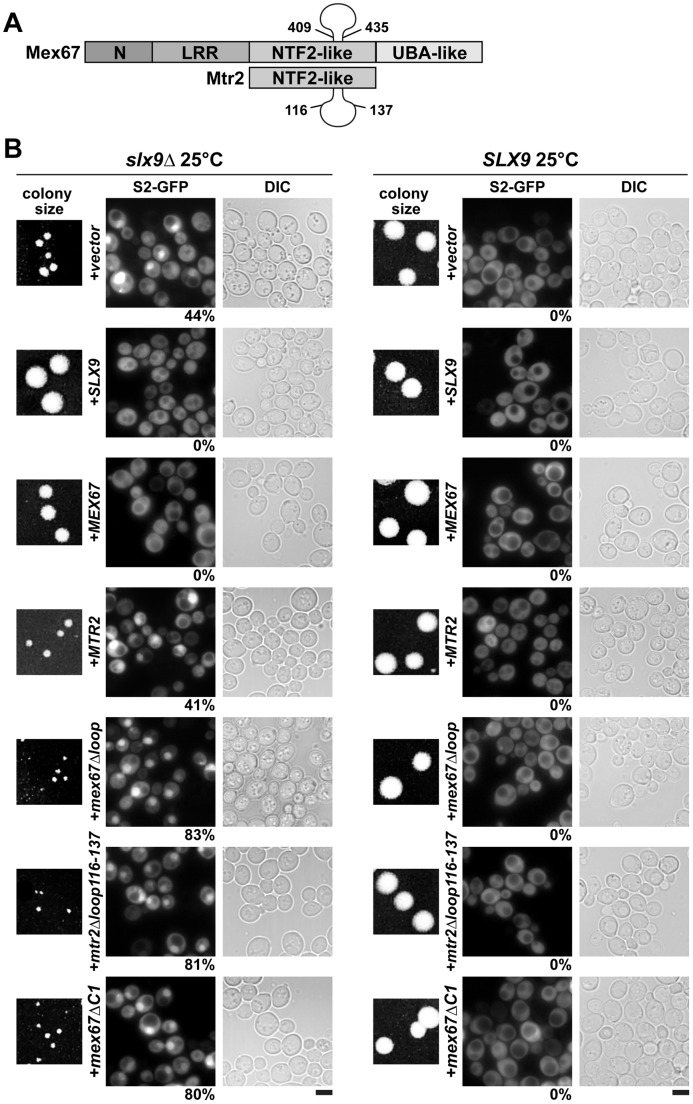
The mex67Δloop, mtr2Δloop116-137, and mex67ΔC1 alleles are dominant negative in the slx9Δ mutant.(A). Schematic depicting domain organization of Mex67 and Mtr2 (not drawn to scale). Residue numbers for the alleles used in this study are indicated. (B) The slx9Δ (left panel) and the SLX9 strain (right panel) were transformed with the indicated plasmids and grown on SD plates for 4 days. Localization of the S2-GFP reporter in slx9Δ mutant and SLX9 cells containing the indicated plasmids were inspected by fluorescence microscopy. Percentage of cells showing nuclear accumulation of S2-GFP is indicated below each picture panel. Bar = 5 µm.